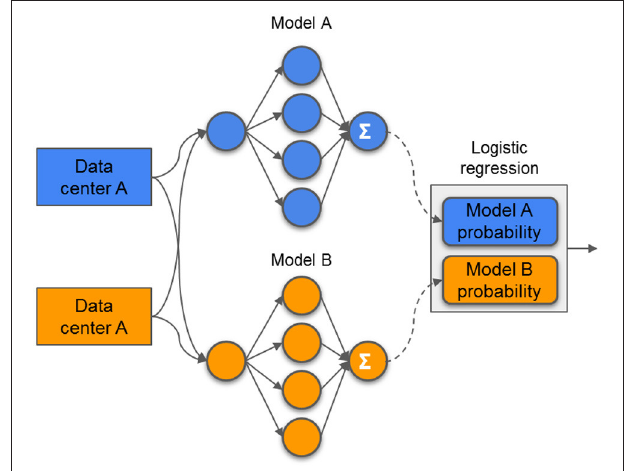
FIGURE 3 | Example of a stacking model. The models are trained independently on each center and its prediction probabilities are used as features to train a single logistic regression